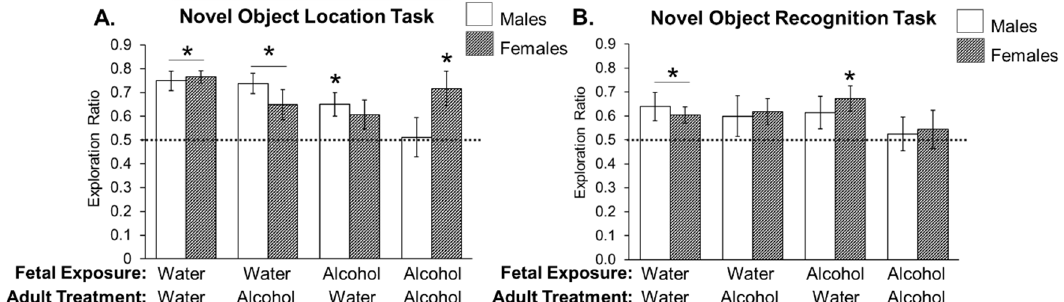
Figure 5. Impact of alcohol exposure (prenatal and adult) on hippocampal-dependent (Novel Object Location) and non-hippocampal-dependent (Novel Object Recognition) learning and memory in male and female rats. Pregnant dams were treated with alcohol or water on E10-16 (2 g/kg, 2 × /day). Offspring were allowed to grow up undisturbed at which point they were taken through the Novel Object Location task and then one week later, the Novel Object Recognition task. The protocol for these tasks is depicted in Figure 1. ( A ) The average discrimination ratio of the time spent exploring the novel location during the three minute task is presented here. * p < 0.05 indicates discrimination ratios significantly greater than chance value (0.5), which is indicative of learning and memory in the task. In particular, all treatment groups were able to learn the Novel Object Location task except females exposed to alcohol prenatally and males exposed to alcohol prenatally and again in adulthood. ( B ) The average discrimination ratio of the time spent exploring the novel object during the three minute task is presented here. * p < 0.05 indicates discrimination ratios significantly greater than chance value (0.5), which is indicative of learning and memory in the task. In particular, only water-treated male and female rats, and the female rats treated with alcohol prenatally were able to learn and remember the Novel Object Recognition task.